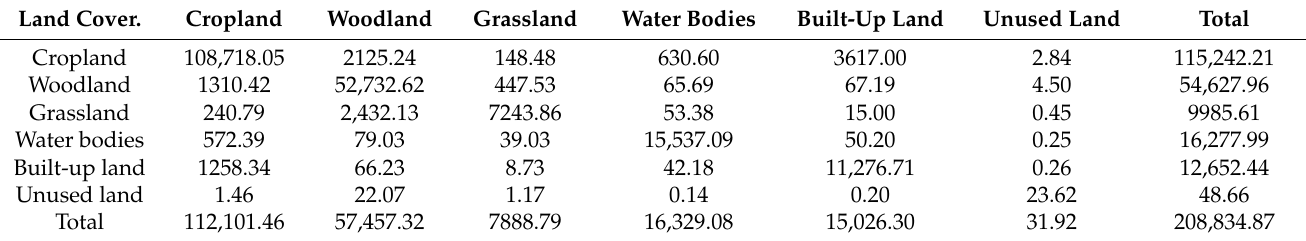
Table 2. Land conversion in Yangtze River Delta Region (1990–1995) (area: km 2 ). Land Cover.